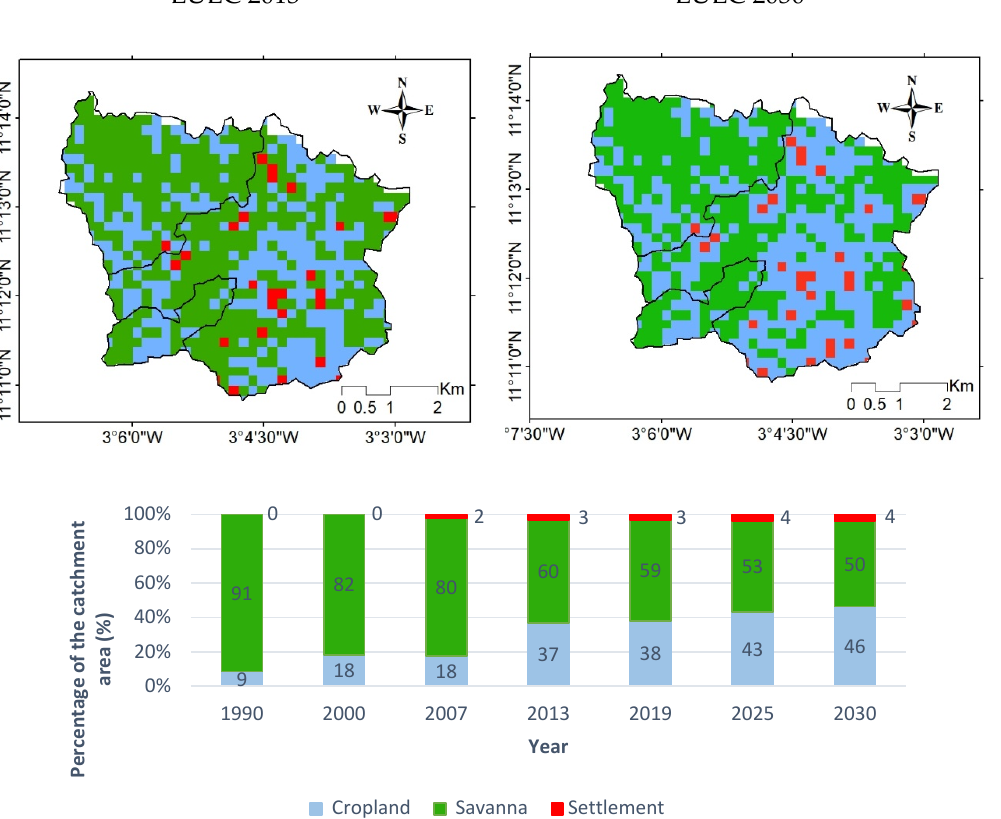
Figure 5. Spatial and temporal variation of historical land use and land cover (LULC 1990, 2000, 2007, and 2013) and the predicted future LULC (years 2019, 2025, and 2030) at a spatial resolution 200 m.